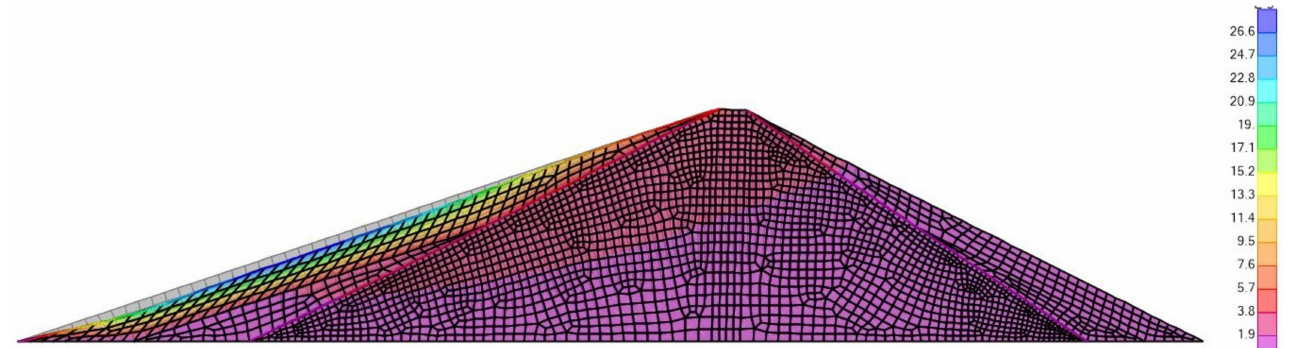
Figure 9. Displacement contours in mm of the mathematical model of the Sanalona dam.